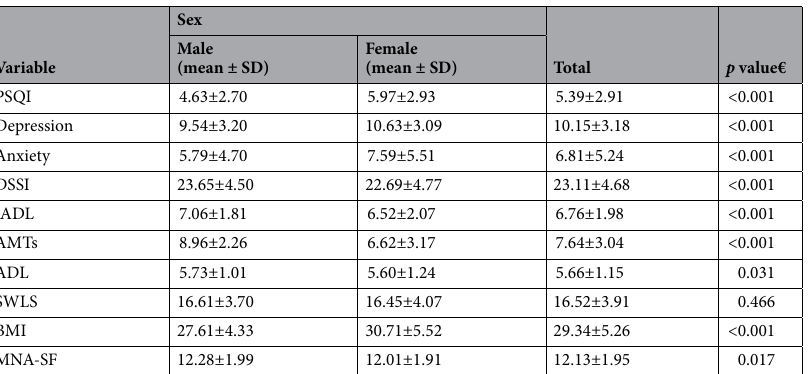
Table 2. Means for the social measures, health status, and disability measures, by sex. Abbreviations: PSQI: Pittsburgh Sleep Quality Index, DSSI: Duke Social Support Index, IADL: Instrumental Activities of Daily Living, AMTs: Abbreviated mental test score, ADL: Activities of Daily Living, SWLS: Satisfaction with Life Scale, BMI: Body Mass Index, MNA-SF: Mini Nutritional Assessment-Short Form. €: P-value calculated by Independent Samples T-Test.